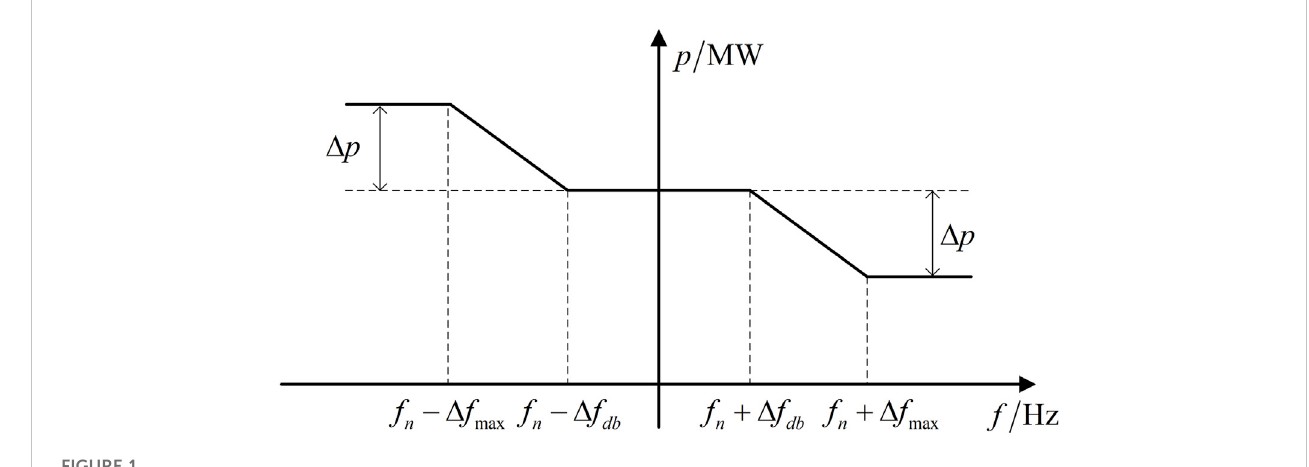
FIGURE 1 Power frequency droop characteristic curve.